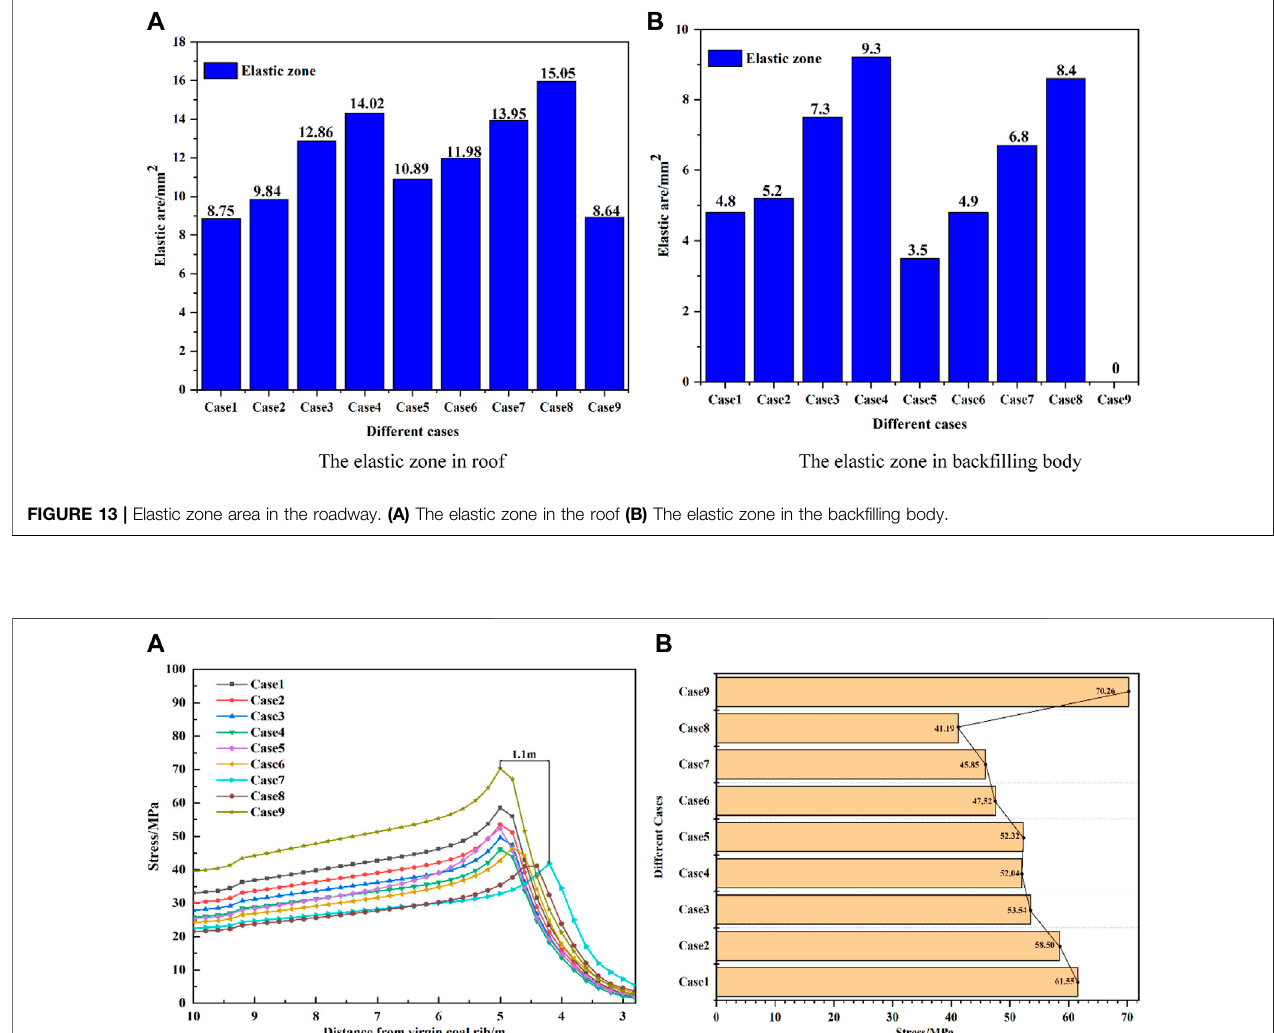
FIGURE 14 | Vertical stress distribution on the integrated coal side. (A) Vertical stress on the integrated coal (B) Vertical stress peak.